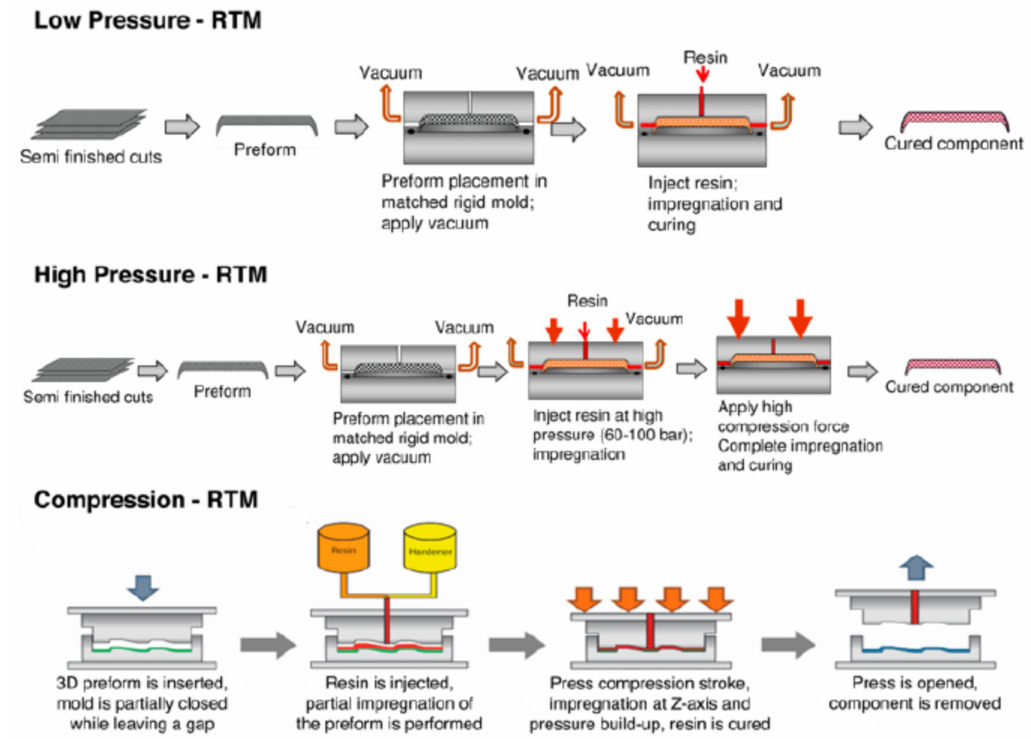
Figure 14. Resin transfer molding (RTM) variants analyzed. Reprinted from [70], © 2020 with permission from